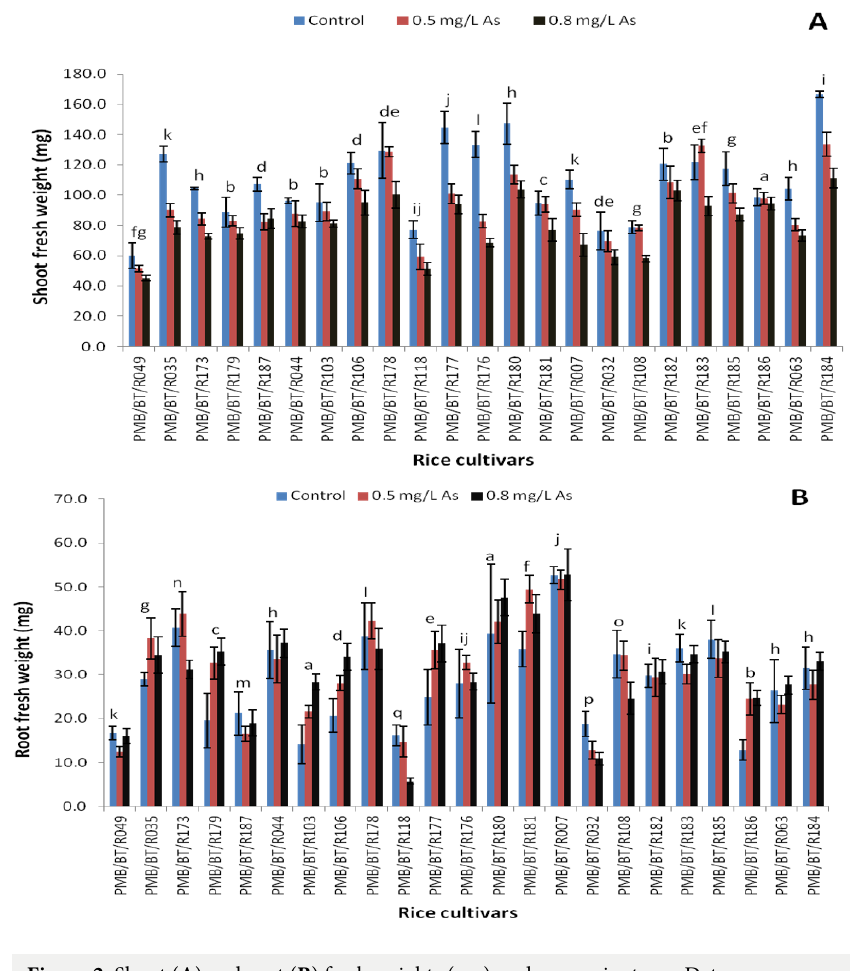
Figure 2 Shoot ( A ) and root ( B ) fresh weights (mg) under arsenic stress. Data are presented as the mean ± SE ; n = 3. Columns topped by the same letter(s) indicate that the percentage changes in the parameter values of the presented cultivars under 0.8 mg/L arsenic stress do not differ significantly at the 5% level according to Duncan’s multiple- range